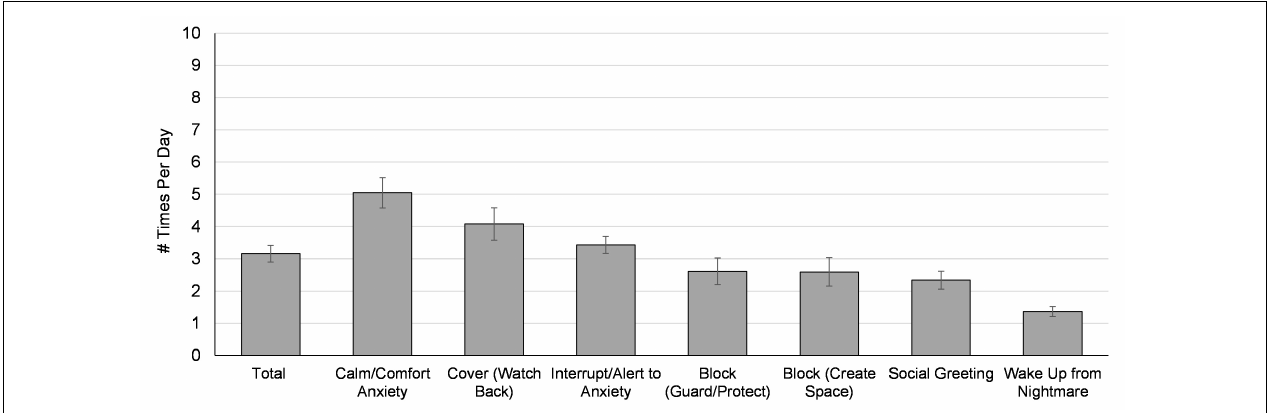
FIGURE 1 | Mean frequency of task use in “a typical day” reported by n = 97 veterans with a service dog, ordered from highest to lowest values. Error bars represent the standard error of the